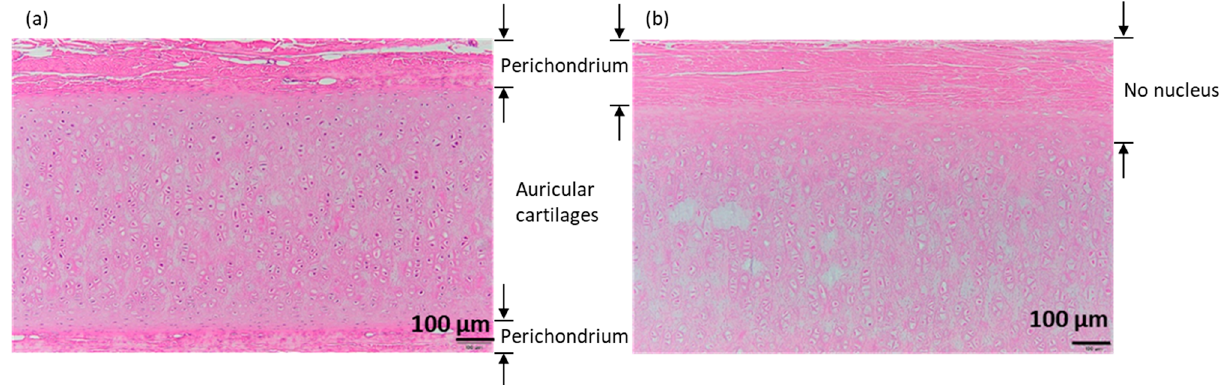
Figure 6. Hematoxylin–eosin staining of 10 × 10 × 1 mm samples. ( a ) Untreated. ( b ) DME extraction followed by DNase treatment for 7 days with degassing. The images shown below are enlarged images of the area enclosed by the rectangle in the upper right corner of the images shown